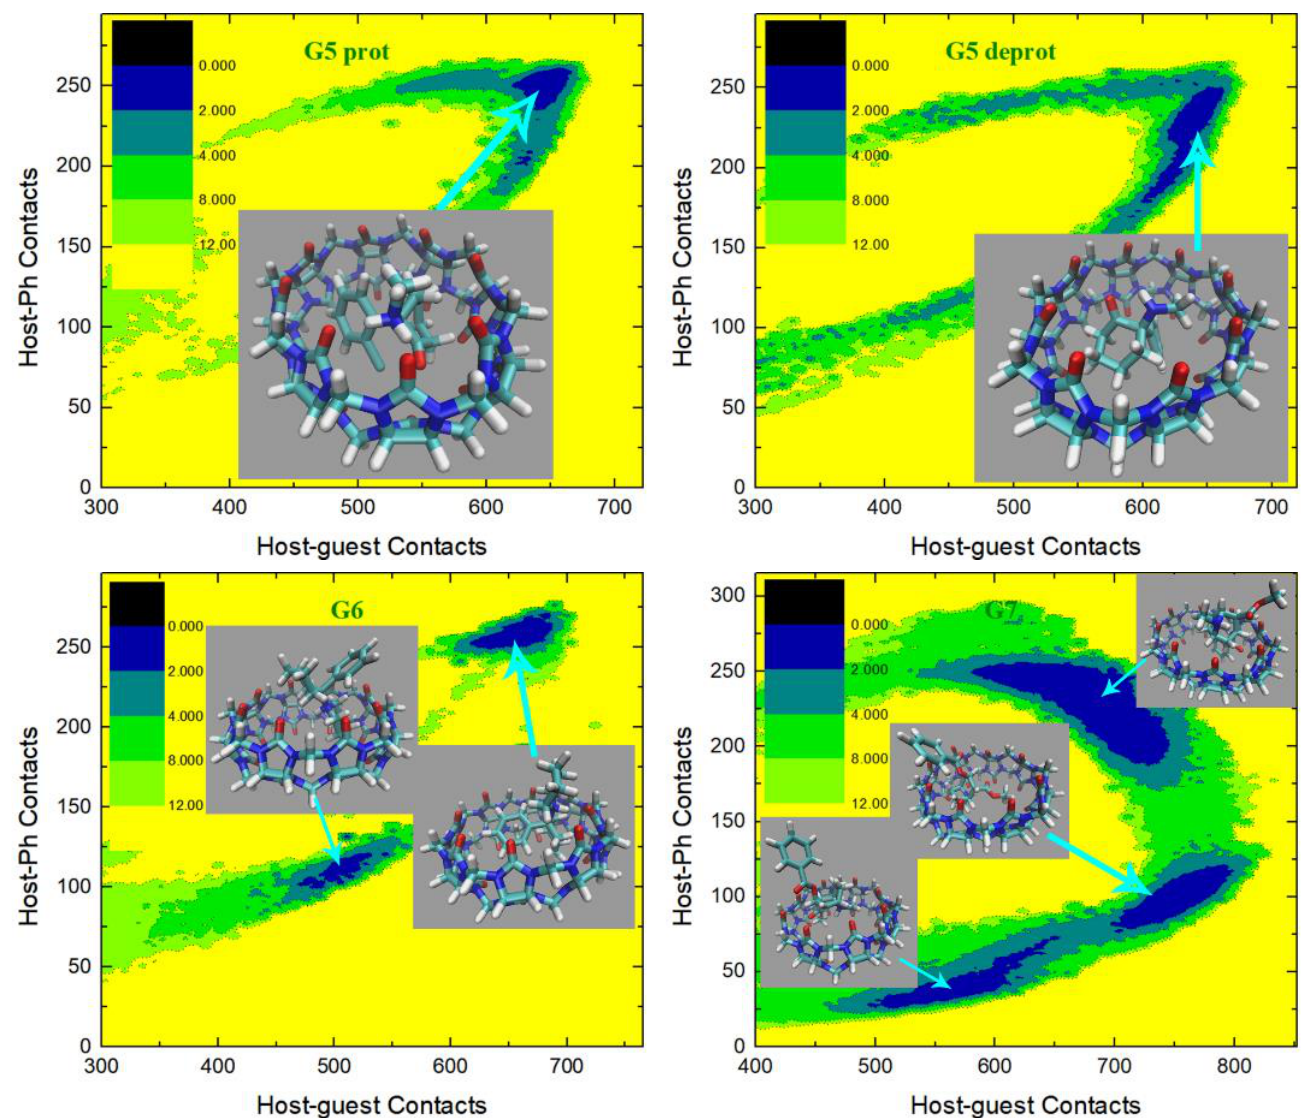
Figure 8. 2D C − C Ph free energy surfaces in kcal/mol obtained under the newly refitted force field FM-BLYP.